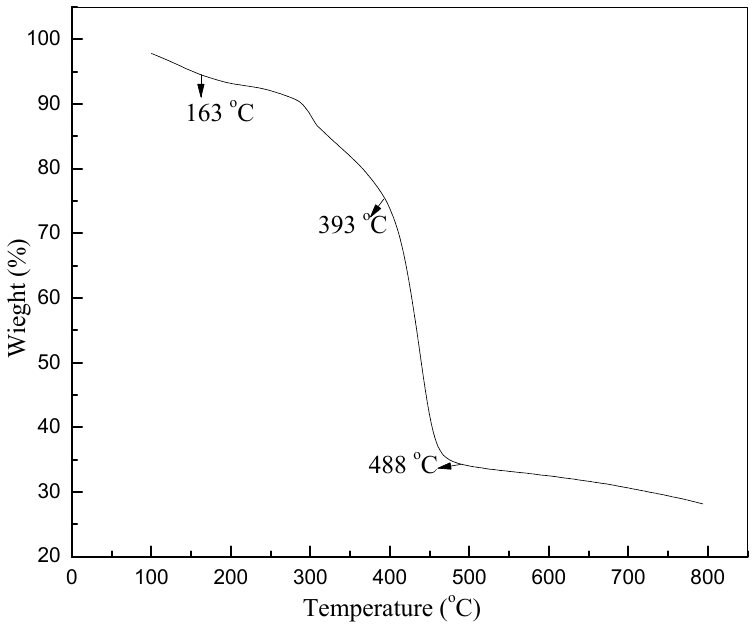
Figure 2. Thermogravimetric analysis (TGA) curve for bimetallic nitrates and PVP.